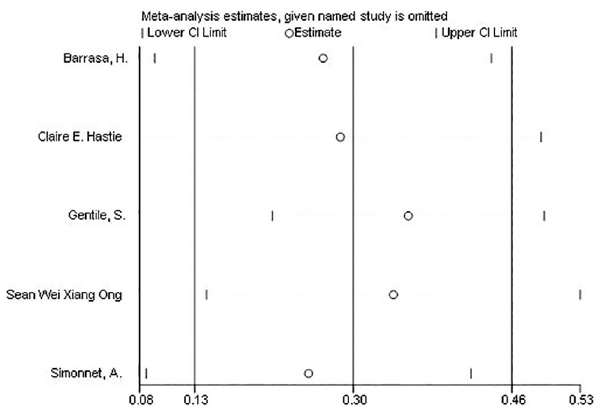
Fig 3. Forest plots of sensitivity analyses of each included study in meta-analysis of the prevalence of obesity in Covid-19 patients.